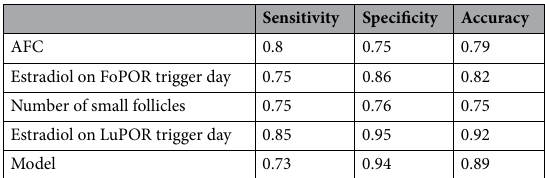
Table 2. Prediction capabilities of the included parameters and of the developed model.